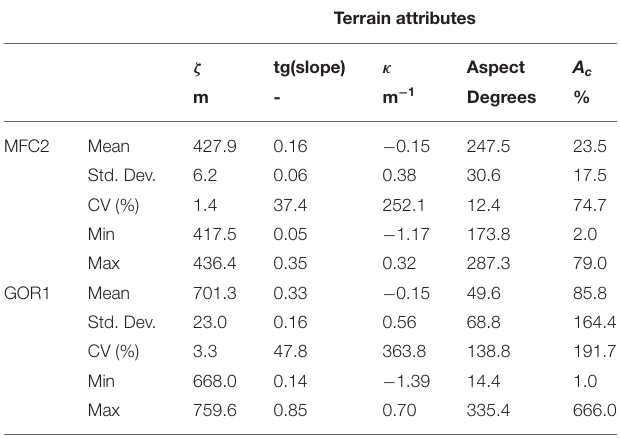
TABLE 2 | Descriptive statistics of terrain attributes, namely elevation ( ζ , above mean sea level), tangent of slope [tg( slope )], tangential curvature ( κ ), aspect, and upslope contributing area ( A c ) for the 20 SoilNet units in both MFC2 and GOR1 sub-catchments. Terrain